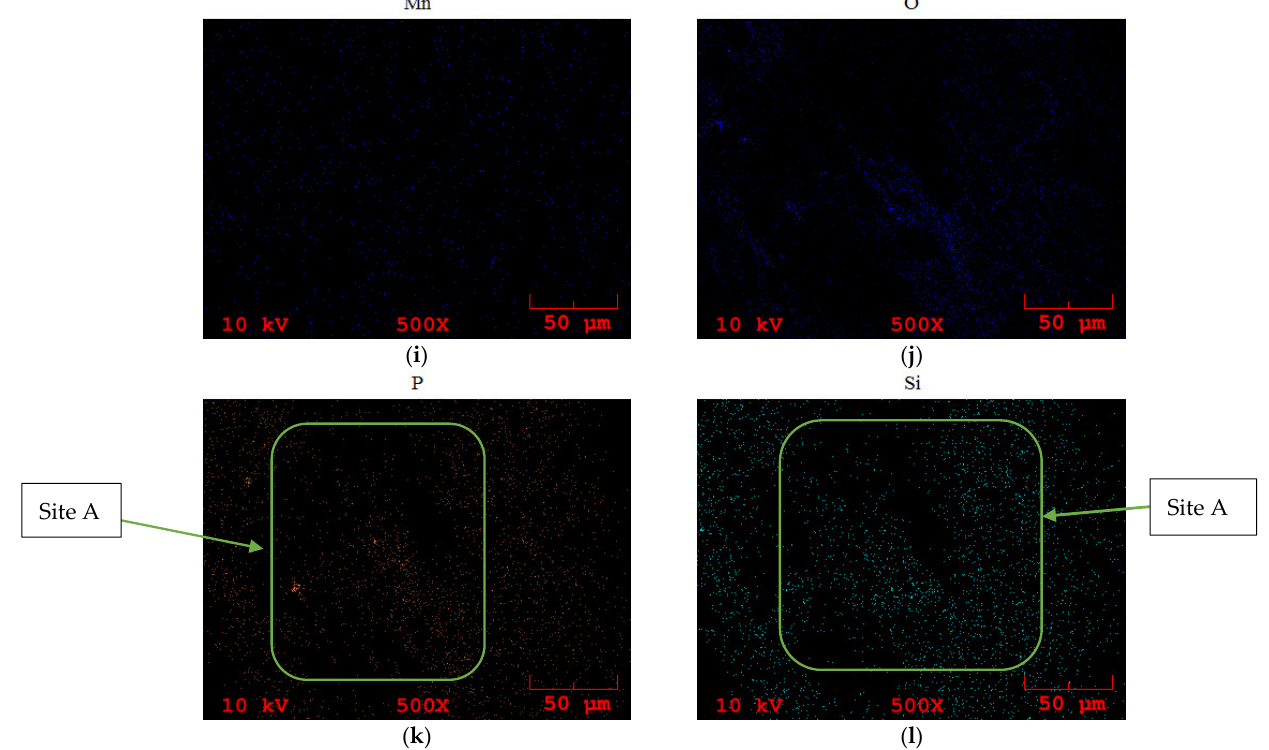
Figure 15. X-ray surface area analysis from inner wood biochar ( a ) SEM surface image ( b ) carbon ( c ) Aluminum ( d ) calcium ( e ) Chlorine ( f ) Iron ( g ) Potassium ( h )magnesium ( i ) manganese ( j ) Oxygen ( k ) Phosphorus ( I ) Silicon distribution on the surface.